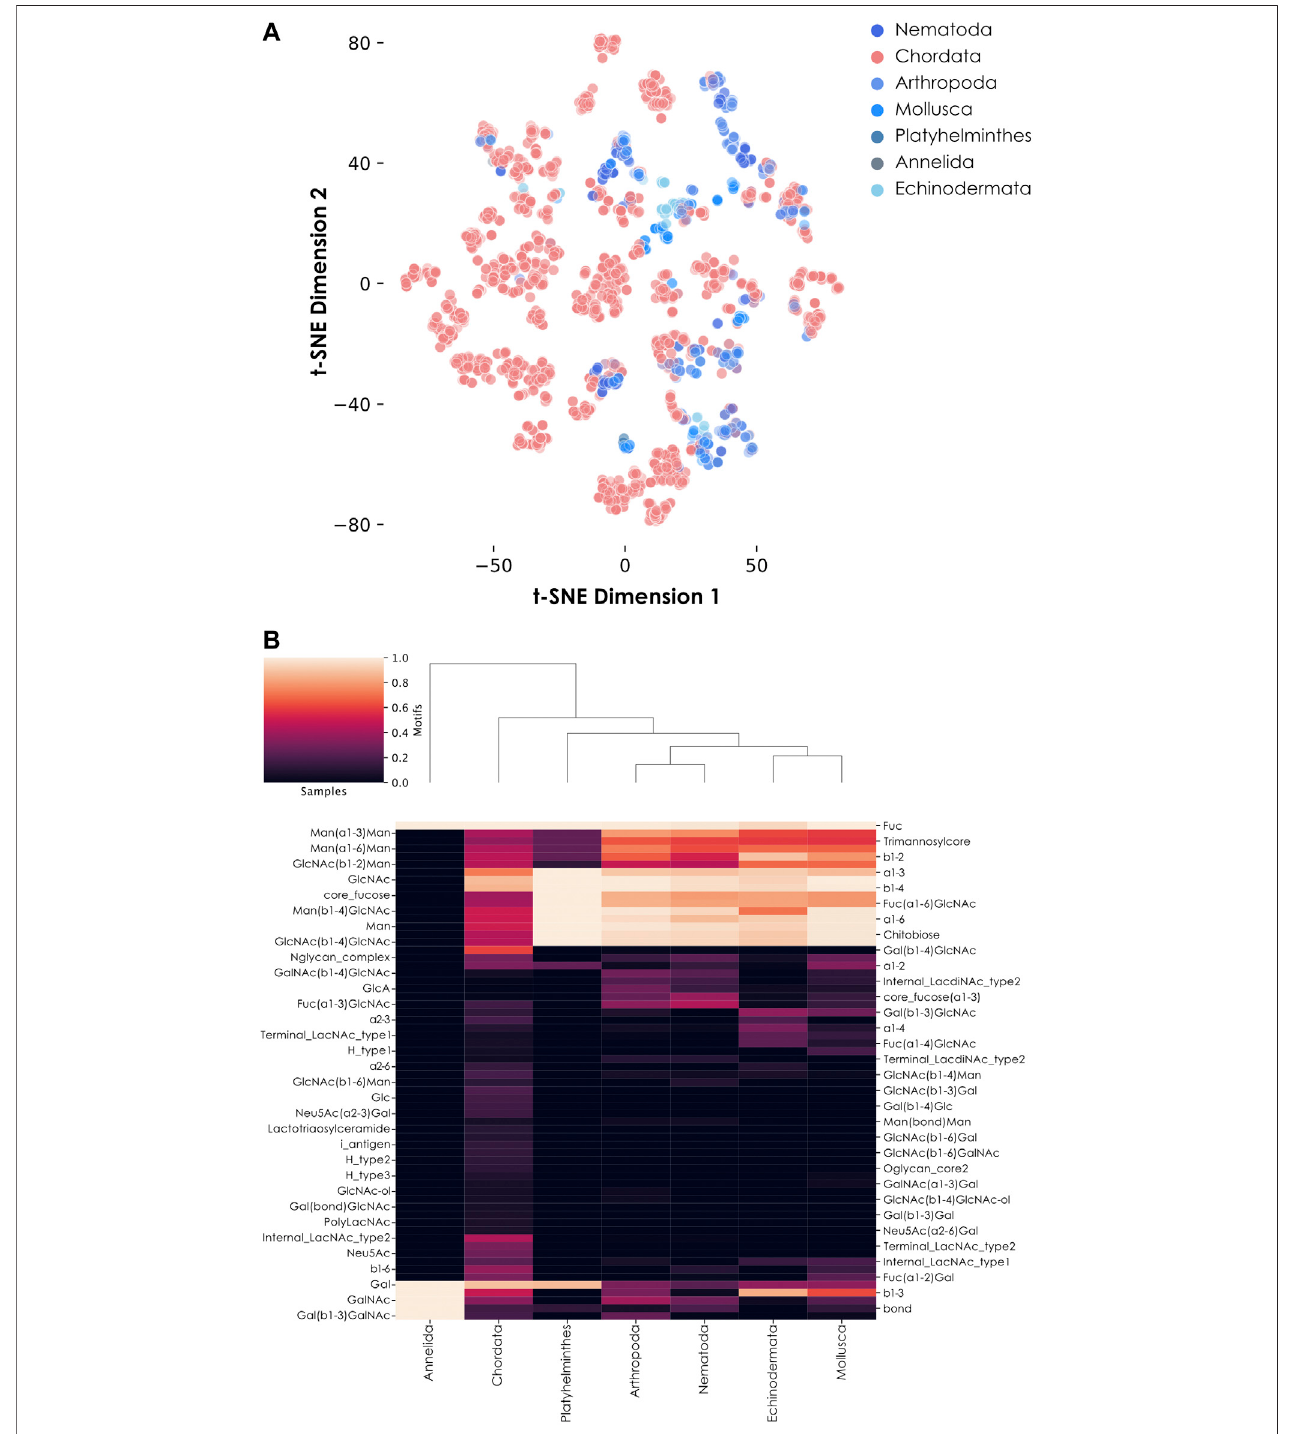
FIGURE 2 | Fucose usage in animal glycans. (A) Diversity of fucose-containing glycans among animals. Fucose-containing glycans from animal species are represented via t-SNE as colored dots, based on their learned similarity from a SweetNet model. Colors indicate the phylum from which they stem. (B) Motif distribution from fucosylated glycans across animal phyla. This heatmap represents the relative abundance of different glycan motifs in each of the seven studied animal groups. Notably, Annelida only contains one fucosylated glycan in our dataset.